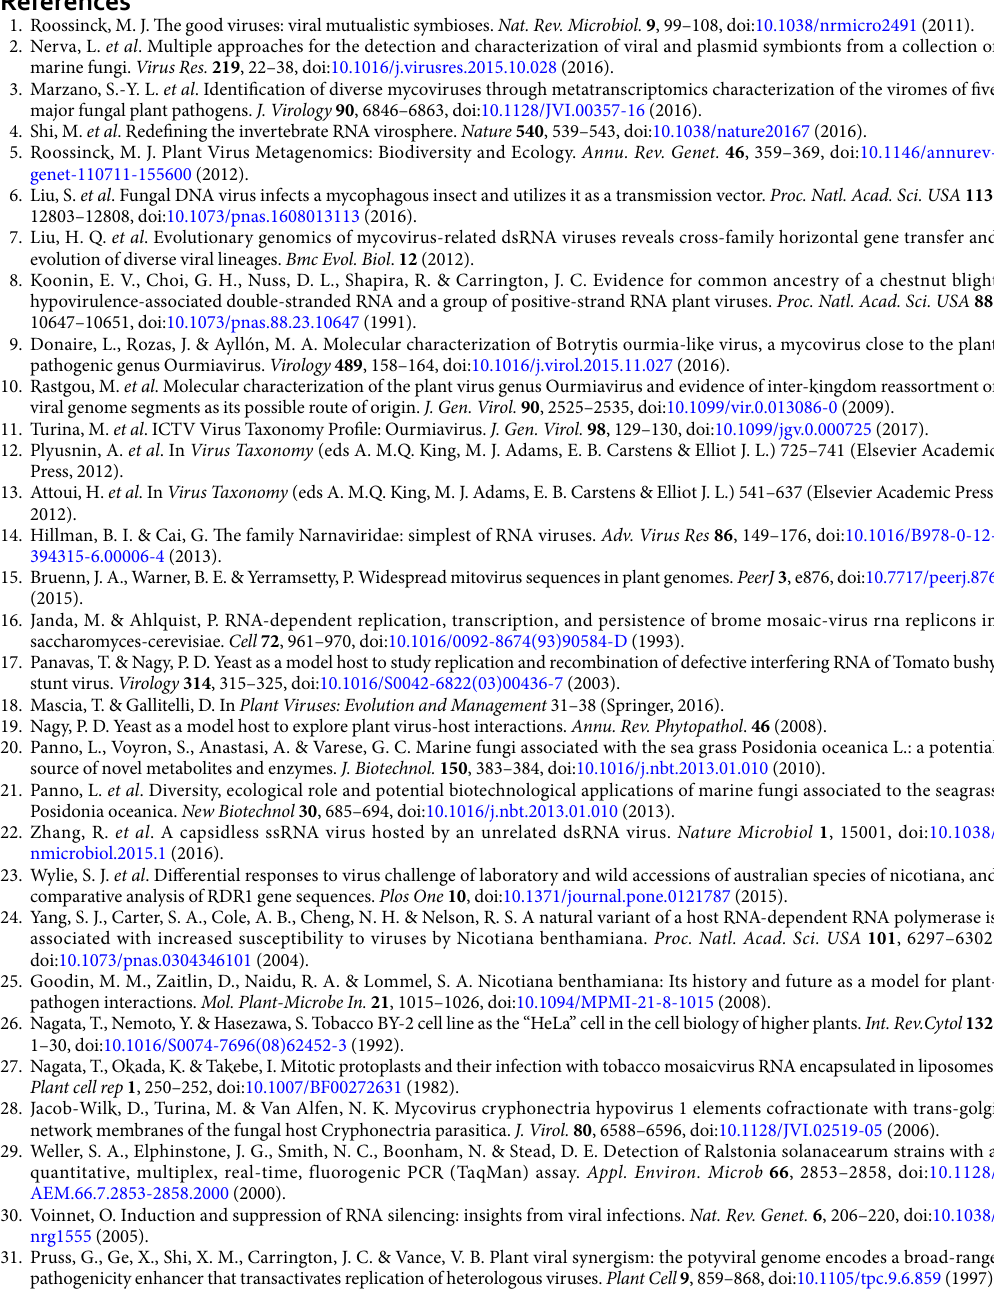
increase in virus accumulation among different time points. For each virus or gene analyzed in the three bio- logical replicates we did three technical replicates in Real time PCR (list of specific primers in supplementary Table 2). Each experiment was repeated at least three times. Relative quantification was calculated using the 2 −ΔΔ Ct method 42 . Viruses re-sequencing from plant protoplasts.